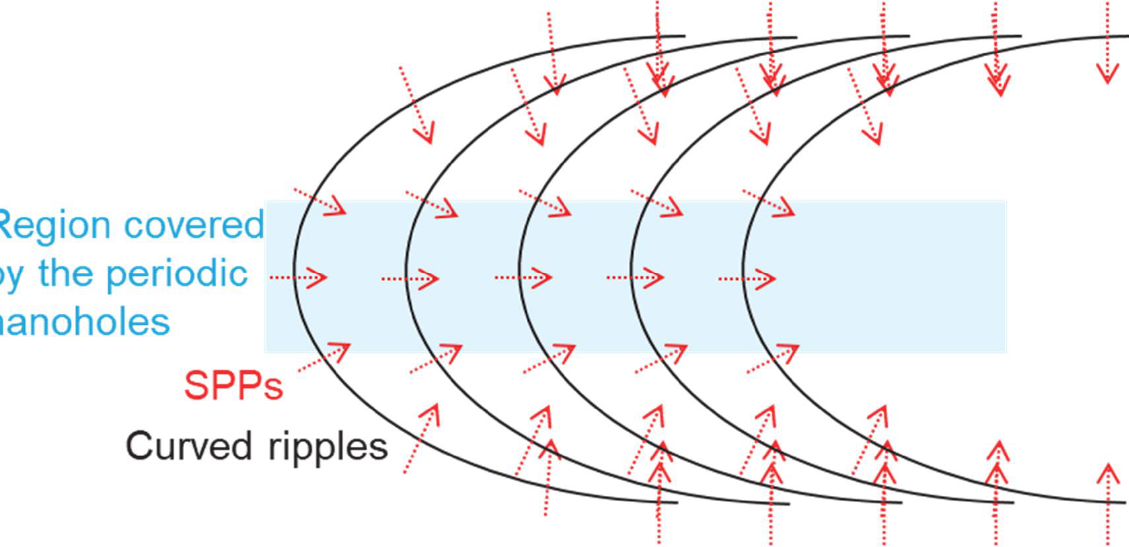
Figure 5. Schematic diagram of converging SPPs induced by the non-cylindrical vectorial femtosec- ond laser beam.